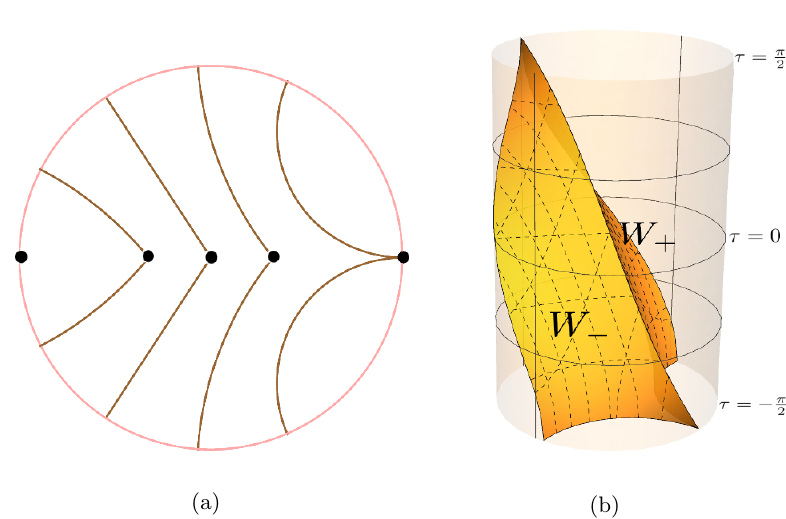
Figure 1 . (a) Cartoon of propagation of a massless particle in the AdS 3 spacetime projected onto synchronous time slices of the AdS 3 cylinder in di(cid:11)erent moments of time. The particle moves from left (right) to right (left), and the spacetime is obtained by cutting out the wedge behind (in front of) the particle between the surfaces W (cid:6) . (b) 3D plot of massless particle moving through the AdS 3 spacetime in global coordinates. The intersection of surfaces W (cid:6) is the worldline of the particle. to set p 2 = 0. Then from the equation above we have 1 u = 1. Thus, the holonomy of